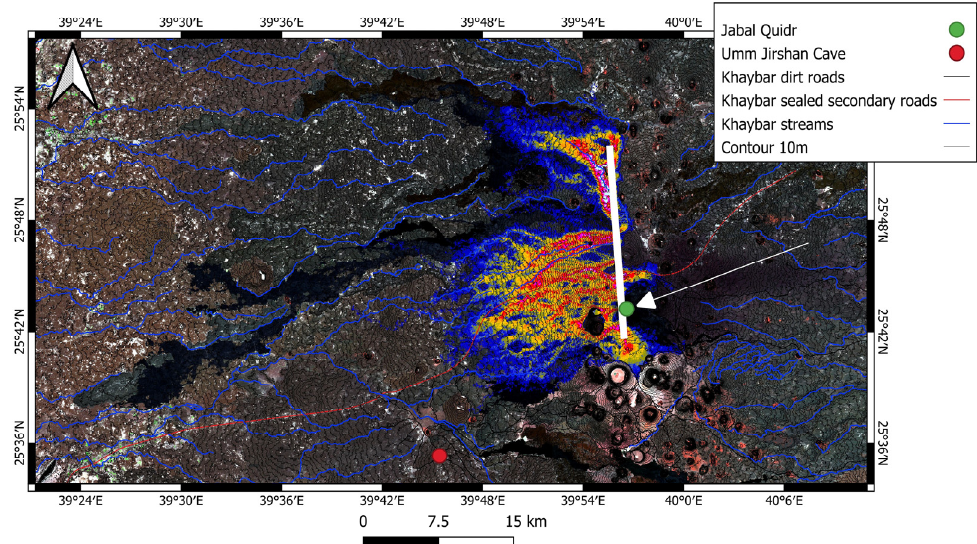
Figure 21. A long fissure simulation that operated by connecting Jabal Quidr (arrow) and the northern vents into a single long fissure, with eruption points spaced 500 m apart applying 500 km simulation distances, provided a very convincing lava flow inundation probability in the proximal regions, but again failed to o ff er inundation in distant regions.